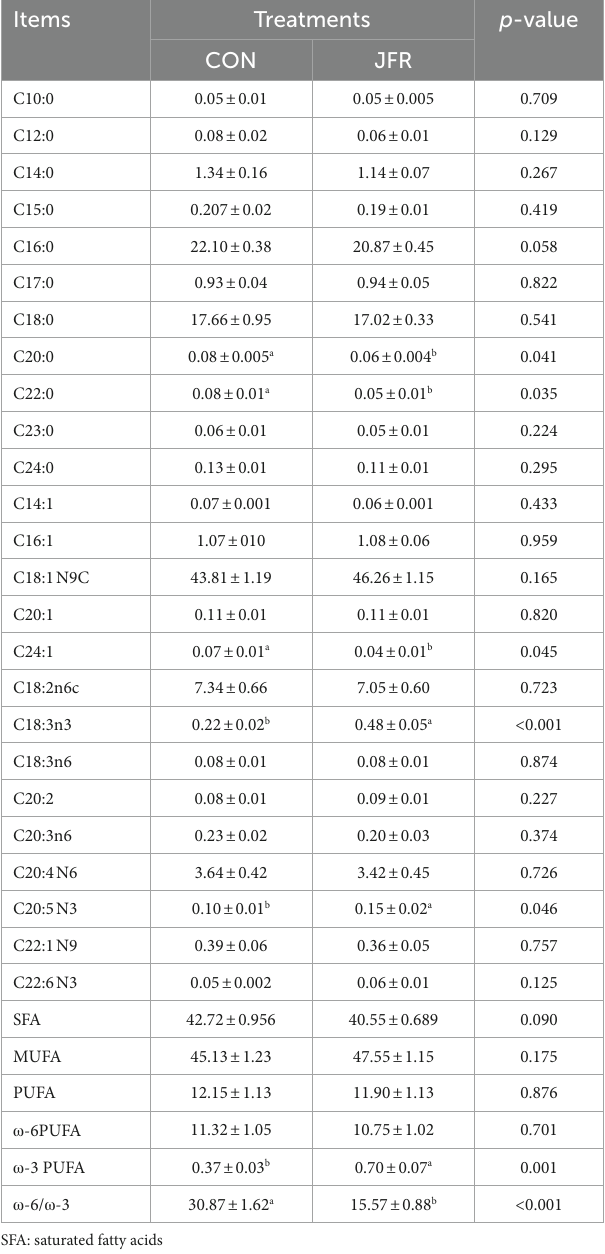
TABLE 3 Effect of dietary jasmine flower residue supplementation on the amino acid composition. Items